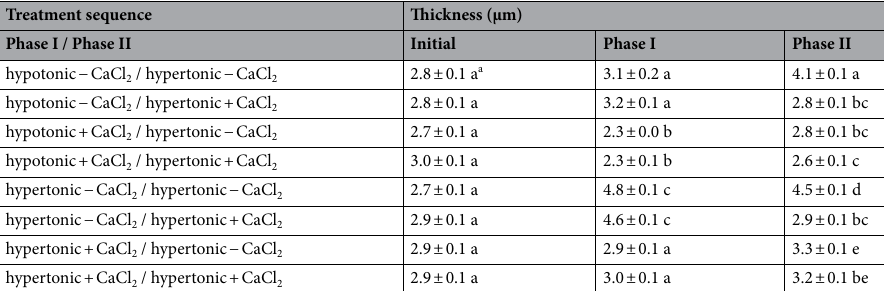
Treatment sequence Thickness (µm) Phase I / phase II Initial Phase I Phase II hypotonic pH 3.0 / hypertonic pH 3.0 hypotonic pH 3.0 / hypertonic pH 5.8 hypotonic pH 5.8 / hypertonic pH 3.0 hypotonic pH 5.8 / hypertonic pH 5.8 hypertonic pH 3.0 / hypertonic pH 3.0 hypertonic pH 3.0 / hypertonic pH 5.8 2.8 ± 0.0 ab 9.3 ± 0.3 a hypertonic pH 5.8 / hypertonic pH 3.0 hypertonic pH 5.8 / hypertonic pH 5.8 Table 6. Effects of pH and turgor on the thickness of anticlinal epidermal cell walls of excised skin segments (ES) of ʻ Adriana’ sweet cherry fruit. a Mean separation within columns, Tukey’s Studentized range test at p < 0.05. Turgor was manipulated by incubating ES in 0.25 M sucrose (‘hypotonic’) or 1.5 M sucrose (‘hypertonic’) at pH 3.0 or pH 5.8. The experiment was conducted by imposing sequential treatments on the same specimens. First, initial thickness of cell walls was measured (‘initial’). The experiment then continued with two phases (phase I / phase II) lasting 24 h each. All solutions were buffered using 10 mM MES. At the end of each phase, cell wall thickness was again measured. Data are means ± SE.